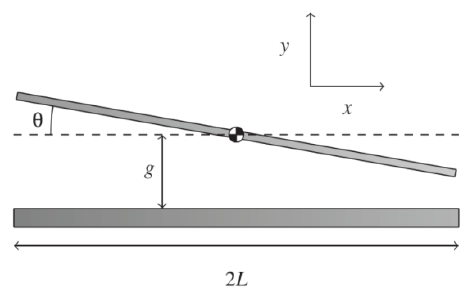
Figure 4. Geometry of the angle-dependent rectangular